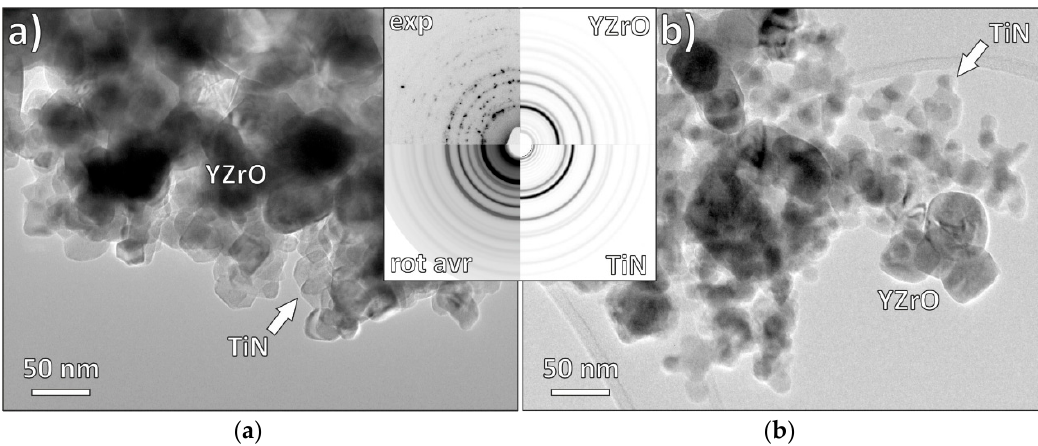
Figure 1. TEM micrographs of ( a ) TiN-coated Y-TZP powder particles (15ISS) and ( b ) admixing of commercial TiN nanopowder with Y-TZP (15MCP). In both cases, the SAEDP (inset; exp = experimental pattern, rot avr = rotational average of experimental pattern, YZrO, and TiN are calculated simulations) corresponds to a mixture of pure tetragonal YZrO and cubic TiN, without intermediates.